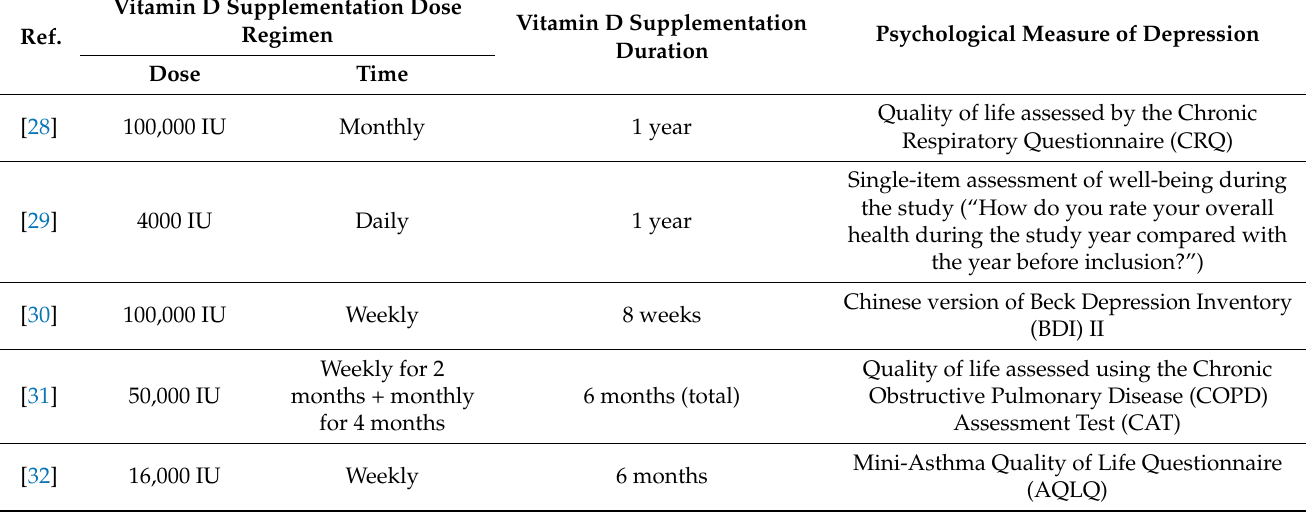
Table 4. The descriptions of the supplementation of vitamin D, accompanied by the descriptions of the assessments of mental health within the studies included in the systematic